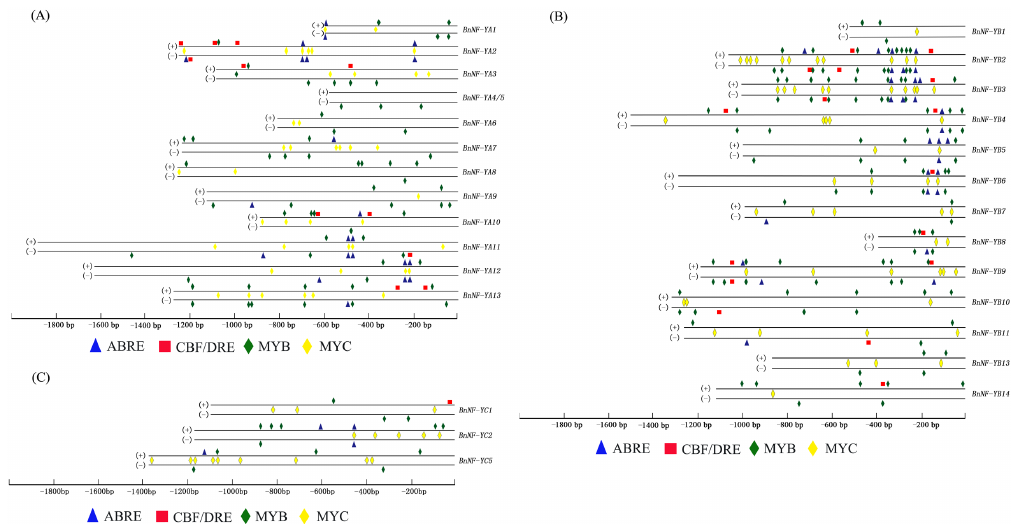
Figure 5. Diagrammatic representation of stress-related elements in the BnNF- Y promoters. Elements in the BnNF- YA (A), BnNF-YB (B), and BnNF-YC (C) promoters. Symbols above the top line indicate elements that are in the forward orientation, and those below the bottom line indicate elements in the reverse orientation. MYC(CANNTG) sequences are between the double lines, to indicate their palindromic nature. Numbers are the distance in nucleotides between the sequences and ATG start codon.